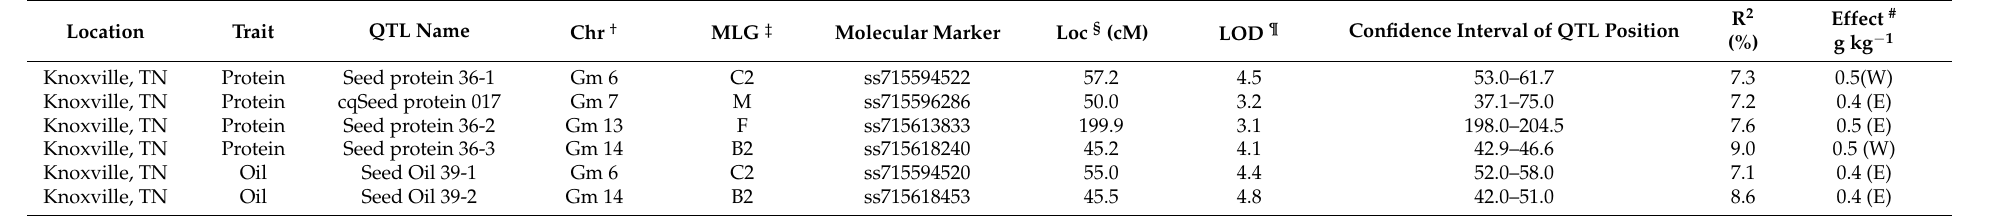
Table 4. Quantitative trait loci identified using R/qtl for composite interval mapping located on various chromosomes associated with protein and oil concentration in. 302 F 5:8 derived recombinant inbred lines of Essex 86-15-1 × Williams 82-11-43-1 grown in 2010 in Knoxville, TN.